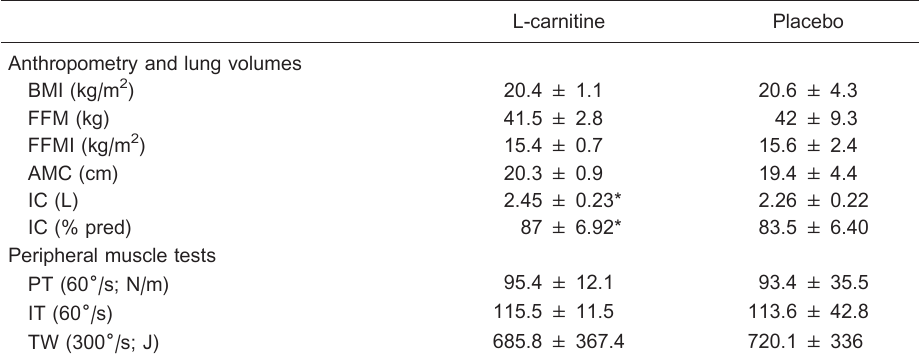
Table 4. Anthropometry, lung function and peripheral muscle performance of mitochondrial myopathy patients, after L-carnitine or placebo supplementation. L-carnitine Placebo Anthropometry and lung volumes